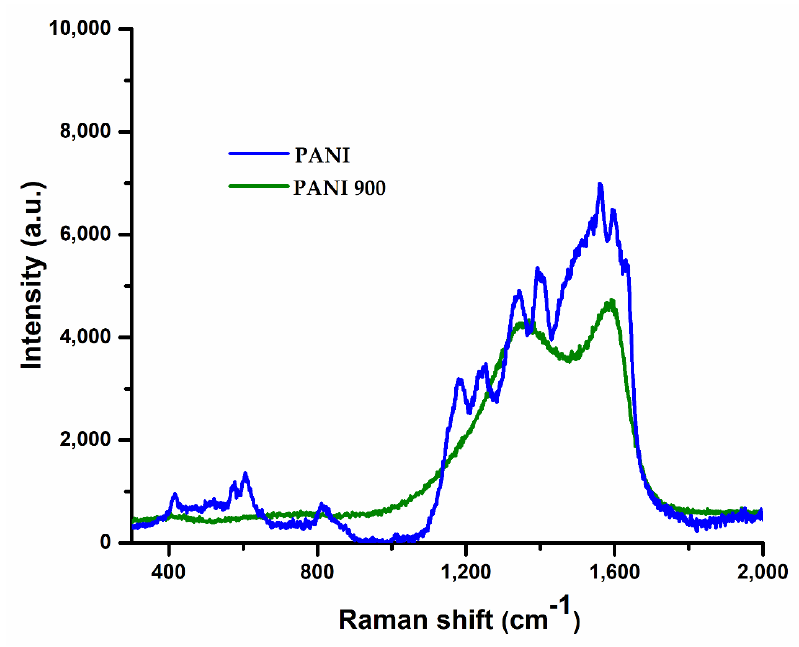
Figure 3. Raman spectra of PANI and PANI 900. Raman spectra of polyaniline show the relatively strong band at ~1594 cm −1 , together with a shoulder at a higher frequency at ~1628 cm −1 , attributed to C=C stretching vibration of the quinonoid ring and C – C stretching of the benzenoid ring vibrations, respectively [54,55]. The band due to the C – C stretching vibration of the quinonoid ring is observed at ~1563 cm −1 . According to other reported results [55,56], the presence of two bands in the range between 1300 and 1400 cm −1 is correlated with an unequal distribution of semiqui- none radical structures in chains. Thus, the band at ~1338 cm −1 corresponds to the C~N + • vibration of delocalized polaronic structures and the band at ~1390 cm −1 corresponds to the C~N + • vibration of more localized polaronic sites. The contribution due to C – N and C – H stretching vibrations in the benzenoid ring is observed at ~1245 cm – 1 and 1180 cm −1 , re- spectively. The bands observed at lower frequencies of 811 cm −1 and 417 cm −1 correspond to benzene – ring deformations and the band at ~606 cm −1 is indicative of ring sulfonation [54 – 57]. Raman spectra of PANI 900 reveal that the molecular structures of carbonized nanostructured PANIs display characteristic features of carbonaceous materials, with two broad maxima centered around ~1375 cm − 1 and 1589 cm − 1 [57]. The peak at a lower wave- number, usually referred to as the disorder induced D – band, is due to the breathing vi- brations of sp 2 sites in six fold aromatic rings, and is commonly associated with structural defects and a reduction in symmetry due to the incorporation of hetero – atoms inside the graphitic lattice. The second band at higher energy, the graphitic G – band, is attributed to the stretching vibration of any pair of sp 2 sites inside the graphitic pattern [58]. The survey scan XPS spectra of polyaniline and corresponding carbon nanostruc- tures were taken for both samples prior to individual elemental scans (N1s) (Figure 4). All samples were calibrated using the BE of graphitic carbon at 284.5 eV. In the case of poly- aniline and corresponding carbon nanostructures, the detected elements and the relative atomic concentrations are shown in Table 1. Table 1. The detected elements and the relative atomic concentrations of PANI and PANI 900.